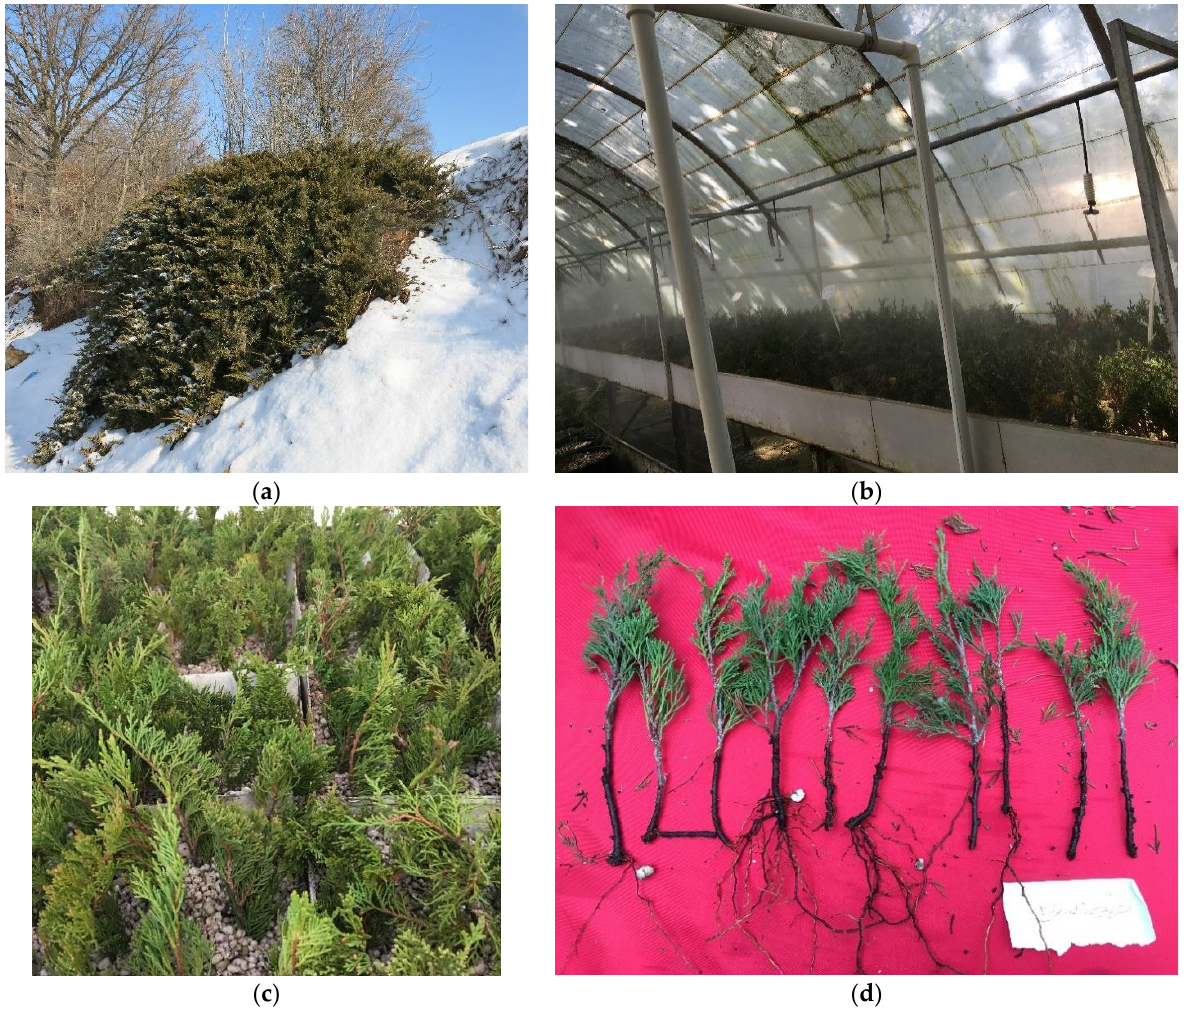
Figure 2. ( a ) Example of Savin juniper plants for collection of stem cuttings in study area; ( b ) greenhouse used to culture stem cuttings under different treatments; ( c ) cuttings growing on substrate; ( d ) example of rooted and unrooted stem cuttings of Savin juniper.